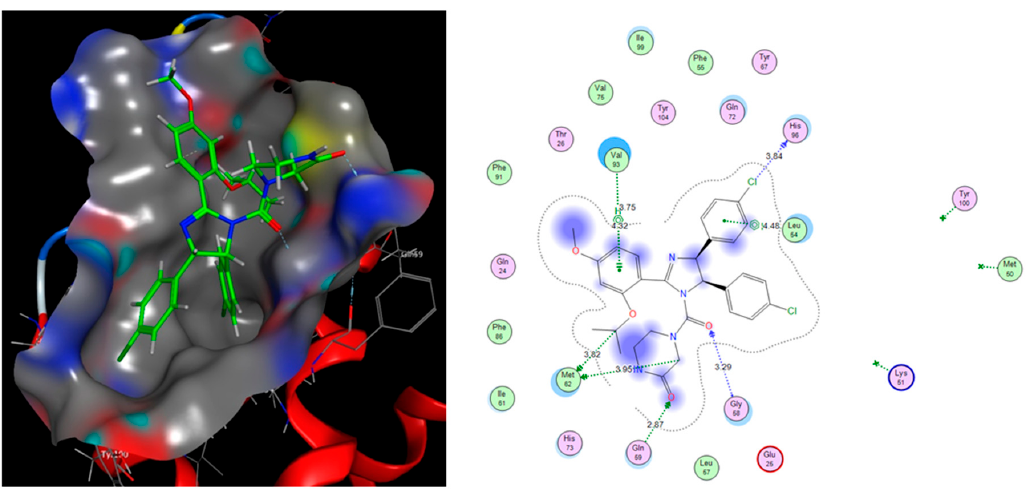
Figure 4. 3D and 2D representations of the protein–ligand (Nutlin-3a) interaction inside the active site of MDM2. Left side of figure: carbon - green , nitrogen - blue, oxygen - red, hydrogen - grey.